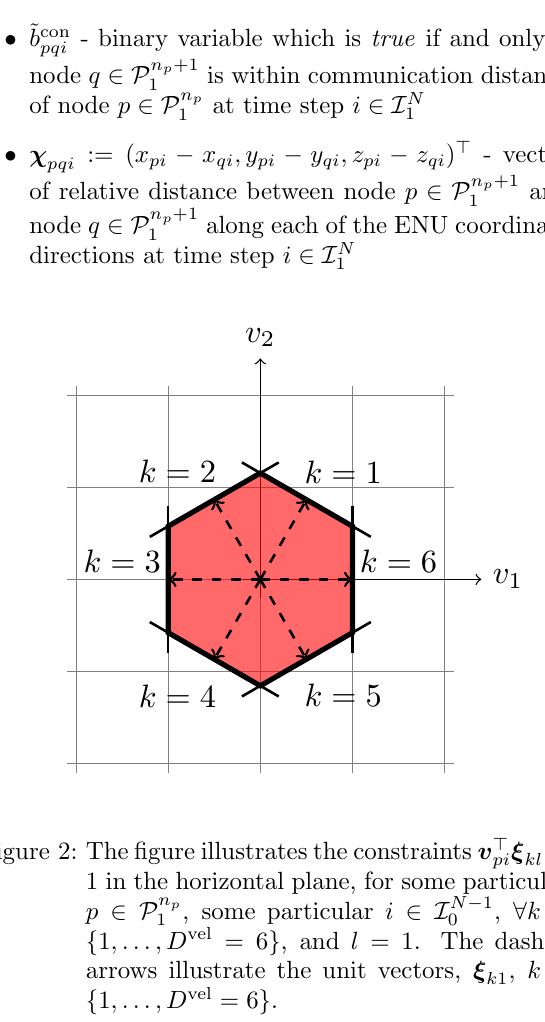
Figure 2: The figure illustrates the constraints v (cid:62) 1 in the horizontal plane, for some particular p ∈ P n p , some particular i ∈ I N − 1 1 { 1 , . . . , D vel = 6 } , and l = 1. The dashed arrows illustrate the unit vectors, ξ { 1 , . . . , D vel = 6 }